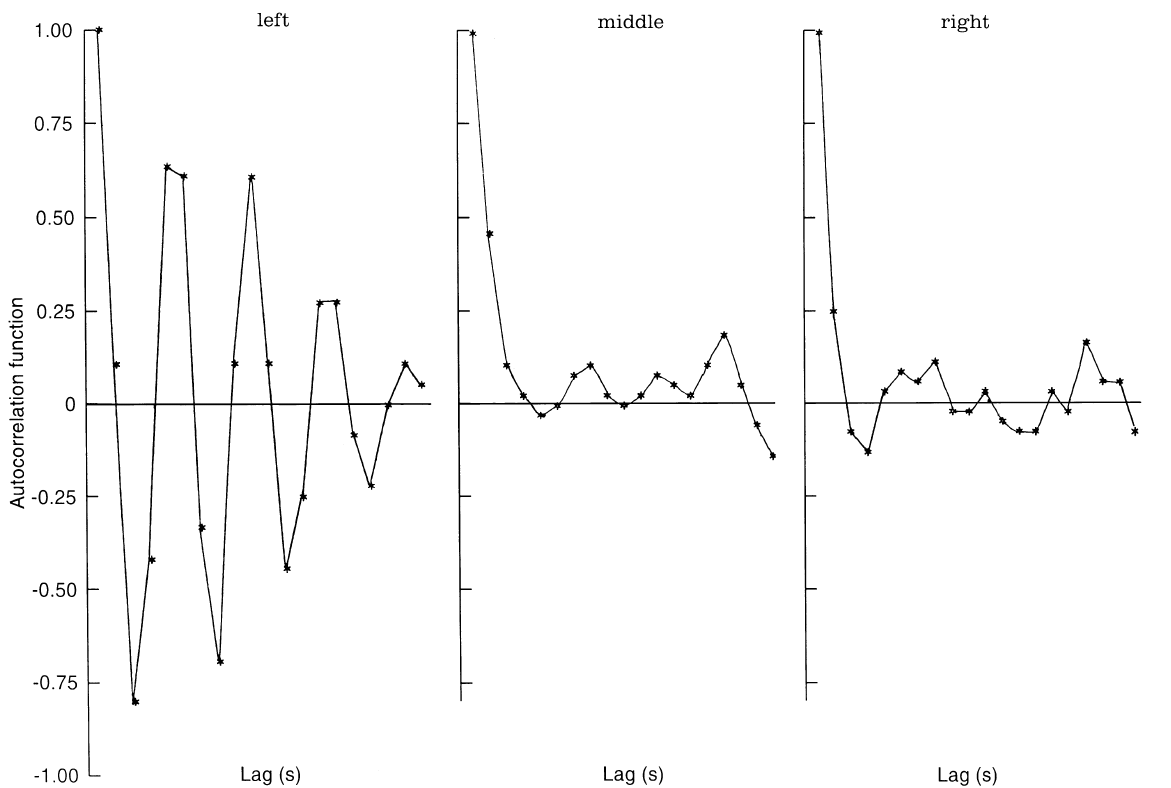
corresponds to a typical narrow-band noise-like process, middle corresponds to a wide band noise process, while right is associated with non-random process. Each lag corresponds to the sampling time, (cid:100) t (cid:136) 0.091 s